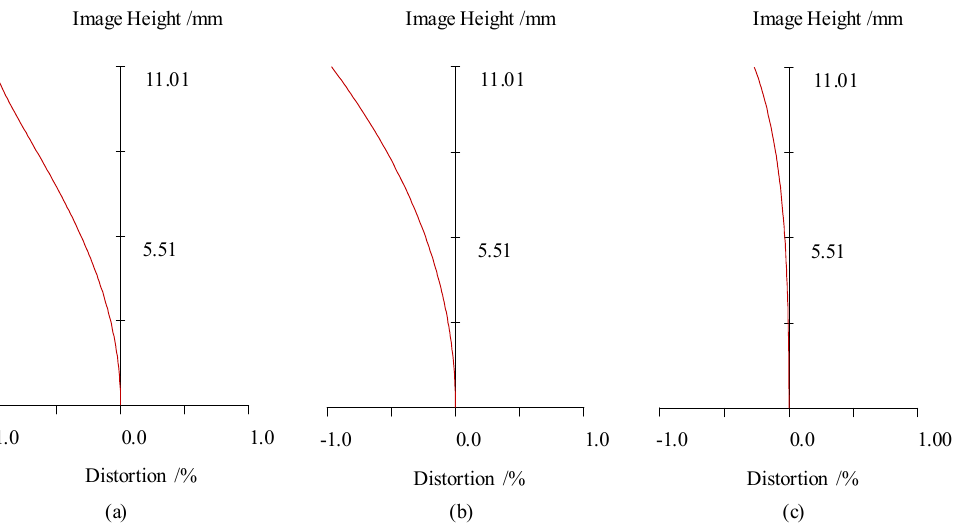
Figure 7. Distortion performance of the zoom optical system at focal length: ( a ) 100 mm; ( b ) 250 mm; and ( c ) 400 mm.